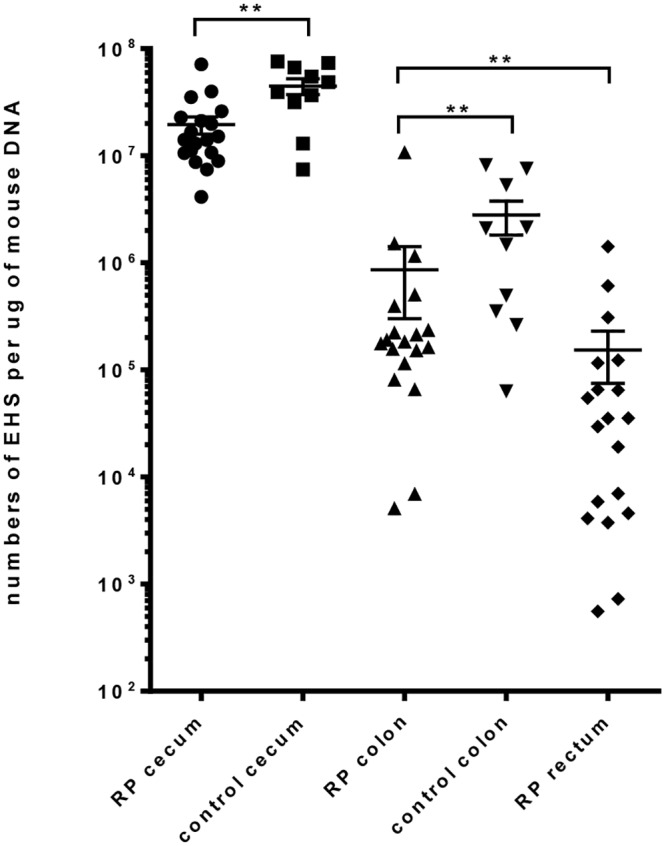
Quantitation of EHS in the Lower Bowel of LPD -/- mice.Levels of EHS colonization were determined by qPCR in the cecum and colon of both RP and CN mice. Organisms were quantified in the rectum only for RP mice, as the normal rectal tissue was less abundant and thus spared for histologic analysis. As expected, EHS were most abundant in the ceca for both groups of mice. Colonization was more variable and tended to decrease distally, yet EHS were still detected in all locations. (RP: Rectal prolapse; CN: Clinically normal).